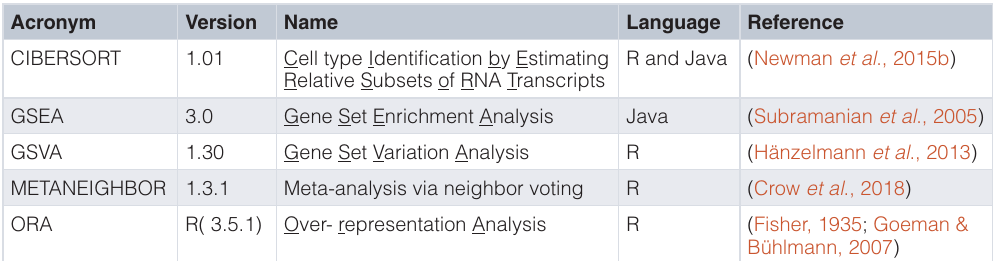
Table 2. Cell cluster labeling methods compared in this